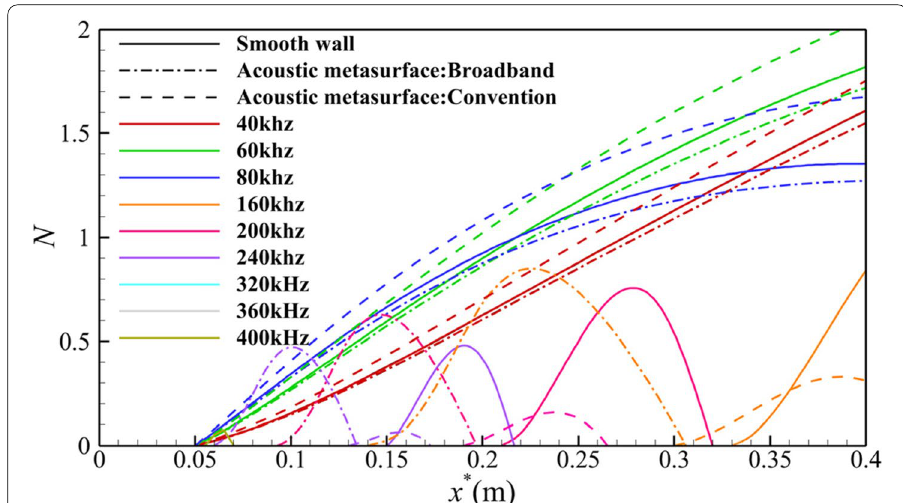
Fig. 8 Comparison of N -factor curves of different